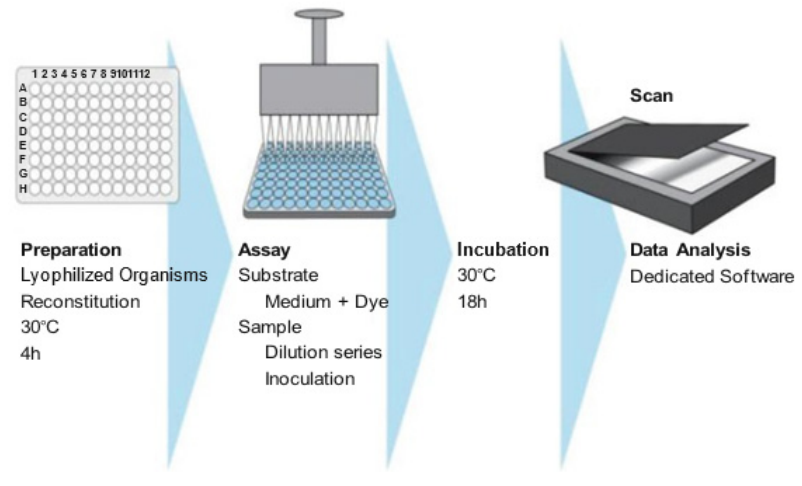
Figure 2. MARA framework.